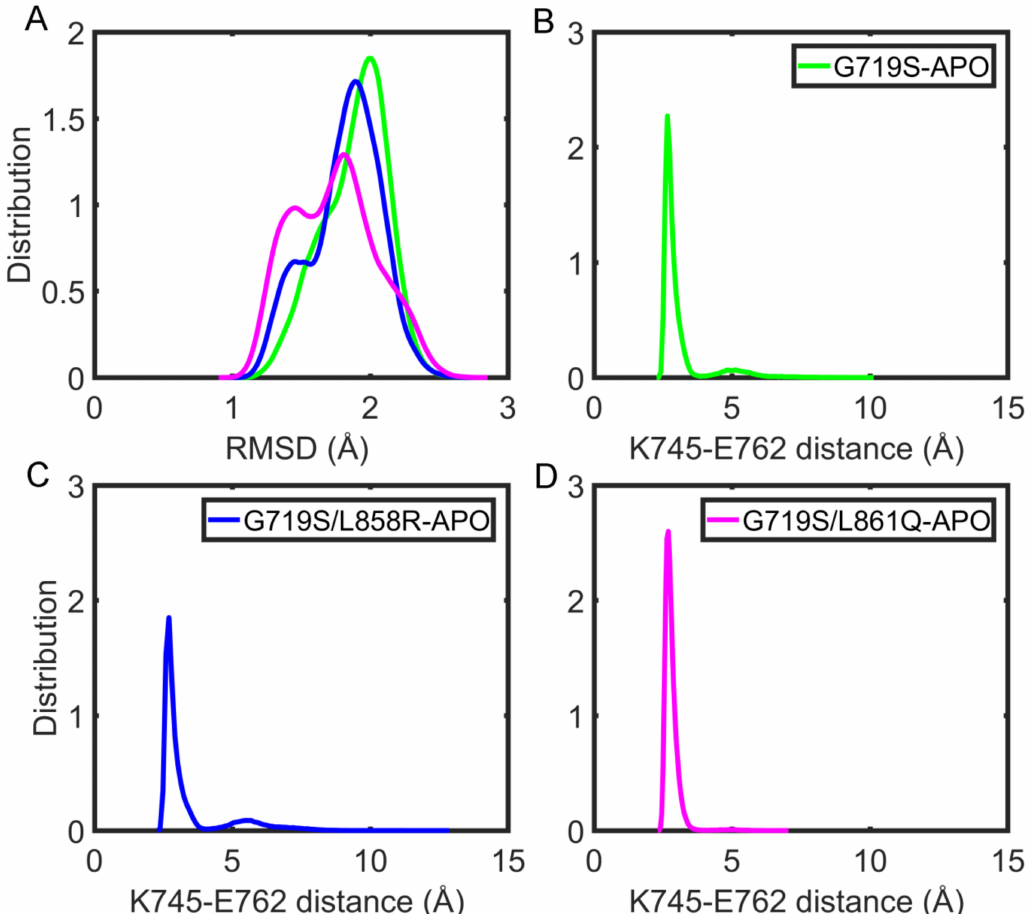
Figure 2. The stability of the α C-helix and KE salt bridge during the simulations for APO systems. ( A ) The RMSD values of the α C-helix backbone atoms in the last 200 ns MD trajectories using the initial structure as the reference. ( B – D ) The probability distribution profile of the distance between atoms K745/NZ and E762/(OE1, OE2) during the last 200 ns is based on all three